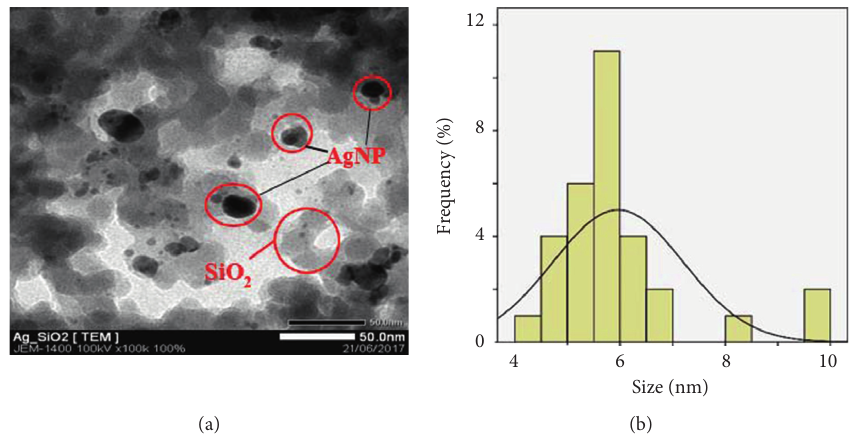
3 -SiO 2 after 2h and 24 h.